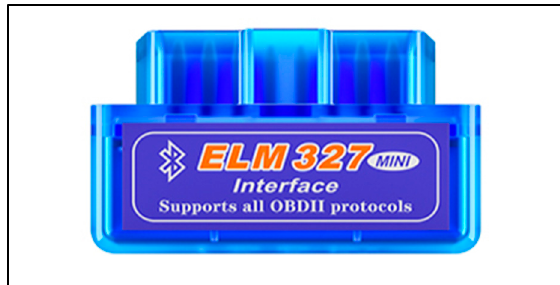
Figure 10. ELM 327 diagnostic tool